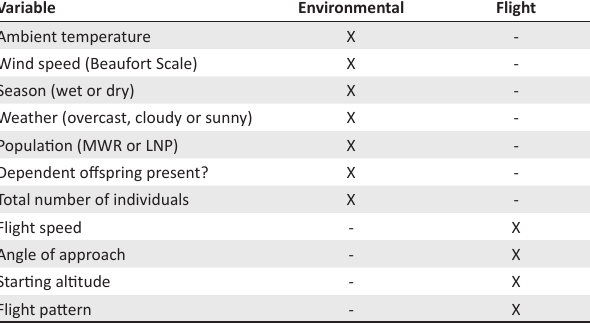
TABLE 3-A1: Input variables used to investigate possible factors influencing drone approach and presence flights around elephants.